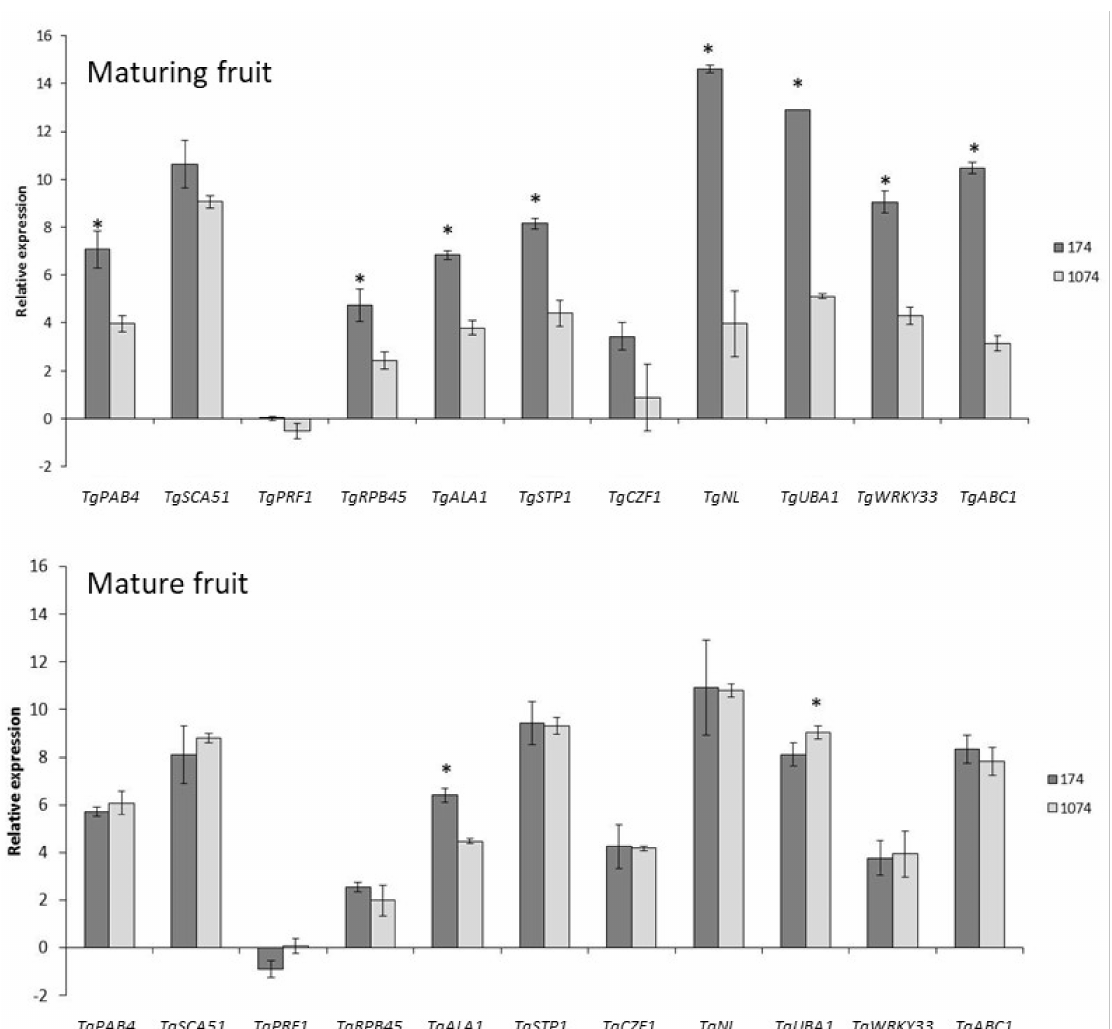
Figure 3. Relative expression of selected genes in seed samples from young, maturing, and mature fruits of contrasting cupuassu genotypes. (*) indicates significant differences between 174 and 1074 genotype samples by t test ( p ≤